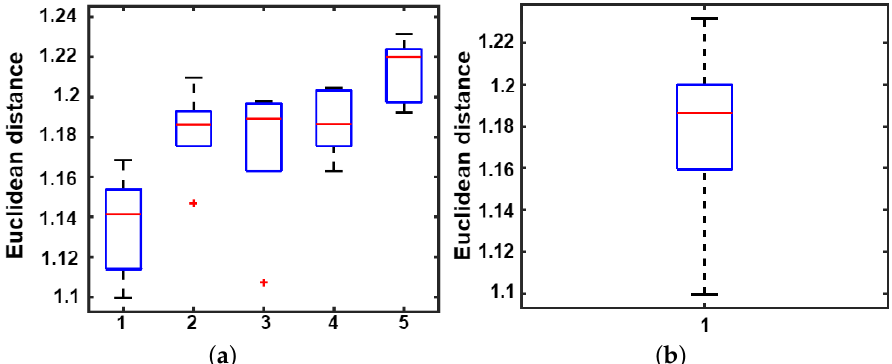
Figure 20. Euclidean distance between the UAS and the trap for the UAS validation. ( a ) Presents a box plot per experiment. ( b ) Single graph with data from all experiments.